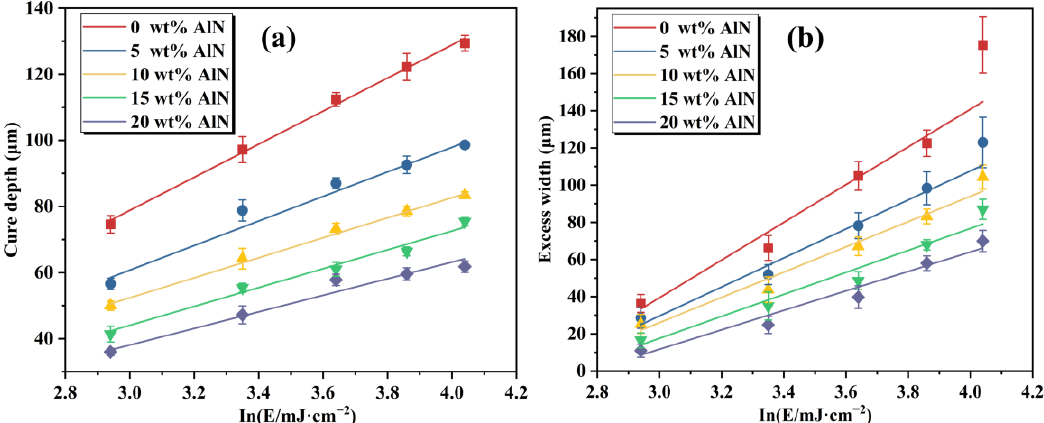
Figure 3. ( a ) The relation of the cure depth and the exposure energy density; ( b ) The relation of the excess cure width and exposure energy density.